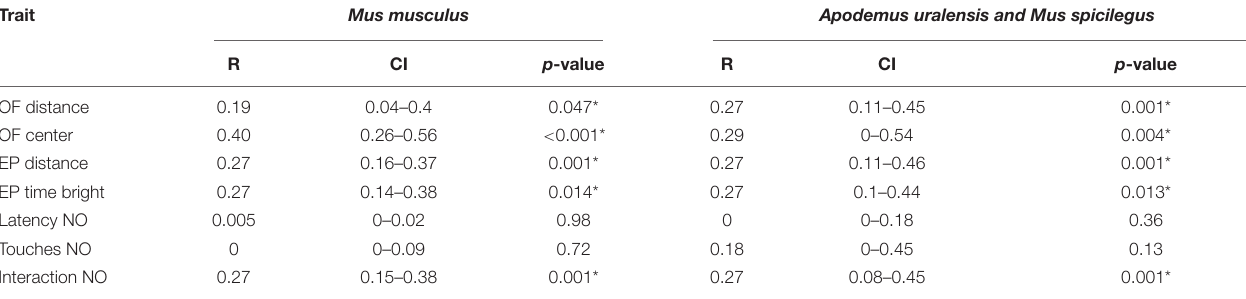
TABLE 1 | Repeatability estimates of behavioral